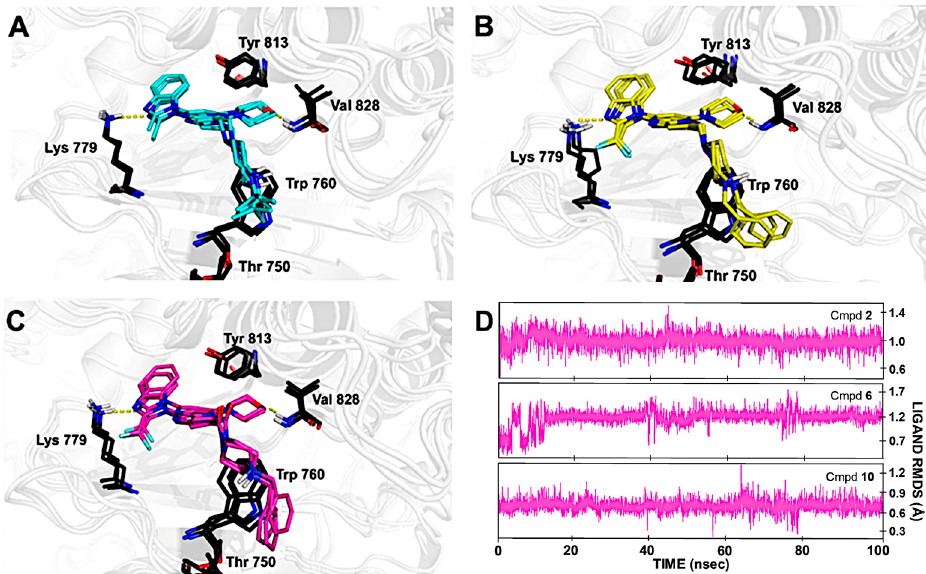
Figure 5. Superposition of the binding modes of core ( A ) tert -butyl piperazine (cyan), ( B ) benzylpiperazine (yellow), and ( C ) 4-benzylpiperazine-1-carbonyl (magenta) in the PI3K δ catalytic sites. The selected complexes were the most populated conformations resulting from the clustering of the MD trajectories. The RMSD (Å) of compounds 2 , 6 , and 10 , respectively, during MD simulations ( D ) indicates the stability of the ligand with respect to the protein and its binding pocket. Ligand RMSD is a measure of the internal fluctuations of ligand atoms.